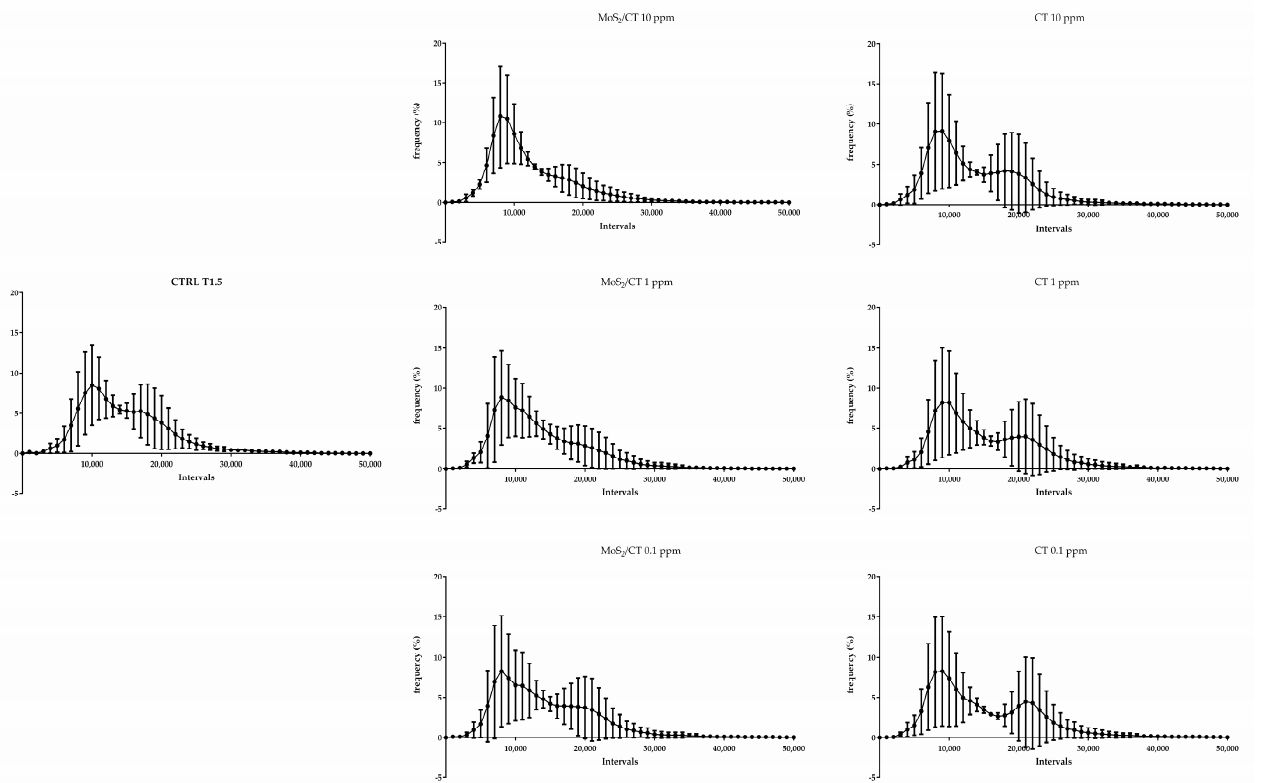
Figure 4. Flow cytometry analysis of membrane disorder and fluidity. The graphs show the frequency of spermatozoa emitting a specific fluorescence intensity, which was subdivided into intervals ranging from 0 to 50,000 a.u. Capacitation was performed up to 1.5 h. DilC-12 was used as a probe. Three independent technical and biological experiments were performed ( n = 3).